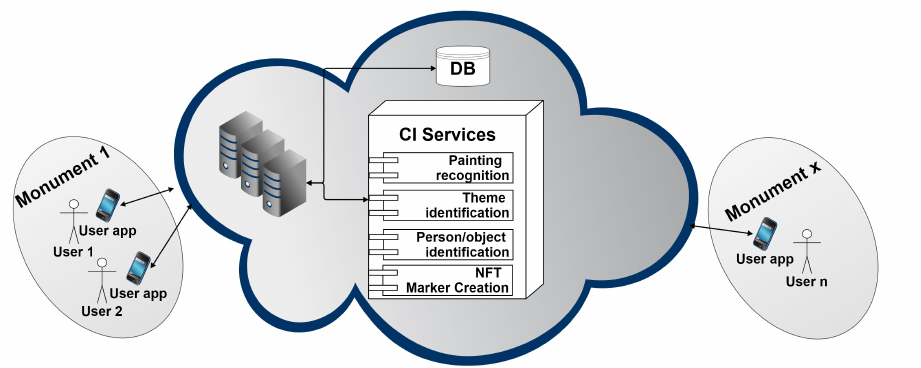
Figure 8. The system’s overall architecture, (i) user’s application; (ii) CI Services; (iii) system’s database.